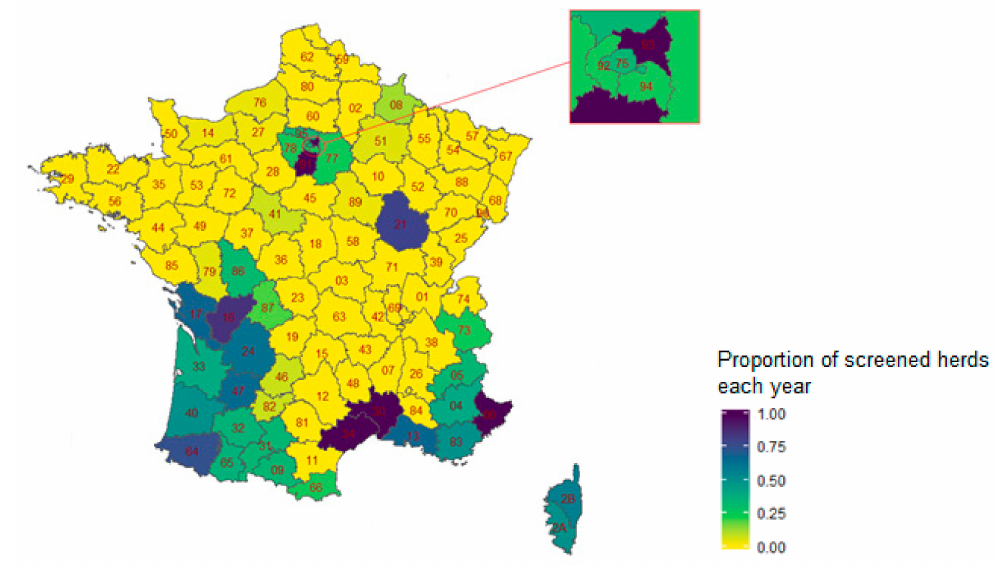
Figure A3. Proportion of herds subject to periodic screening each year as modeled in the scenario